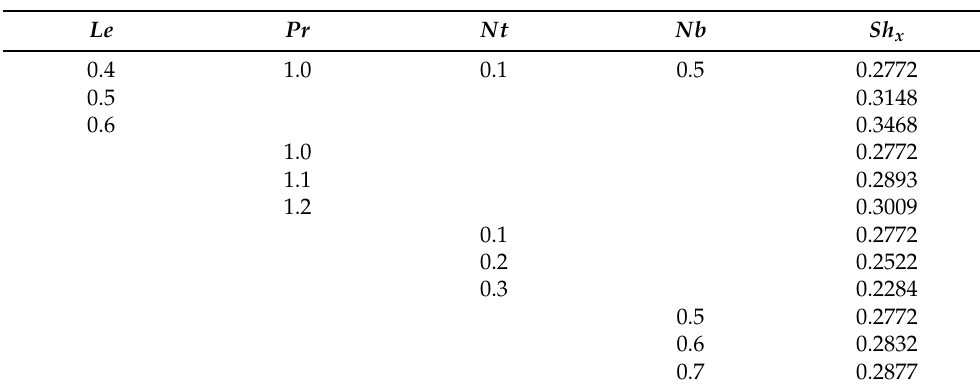
(cid:18) (cid:113) (cid:19) − 1 m + 1 ( − h (cid:48) ( 0 )) 2 x Sh x = 2